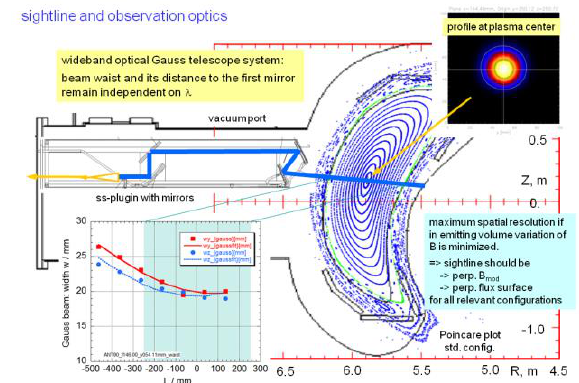
Fig. 1: Cut through the W7-X plasma and -vessel at the poloidal plane of the ECE sightline and the Gaussian telescope optics plugin in the diagnostic